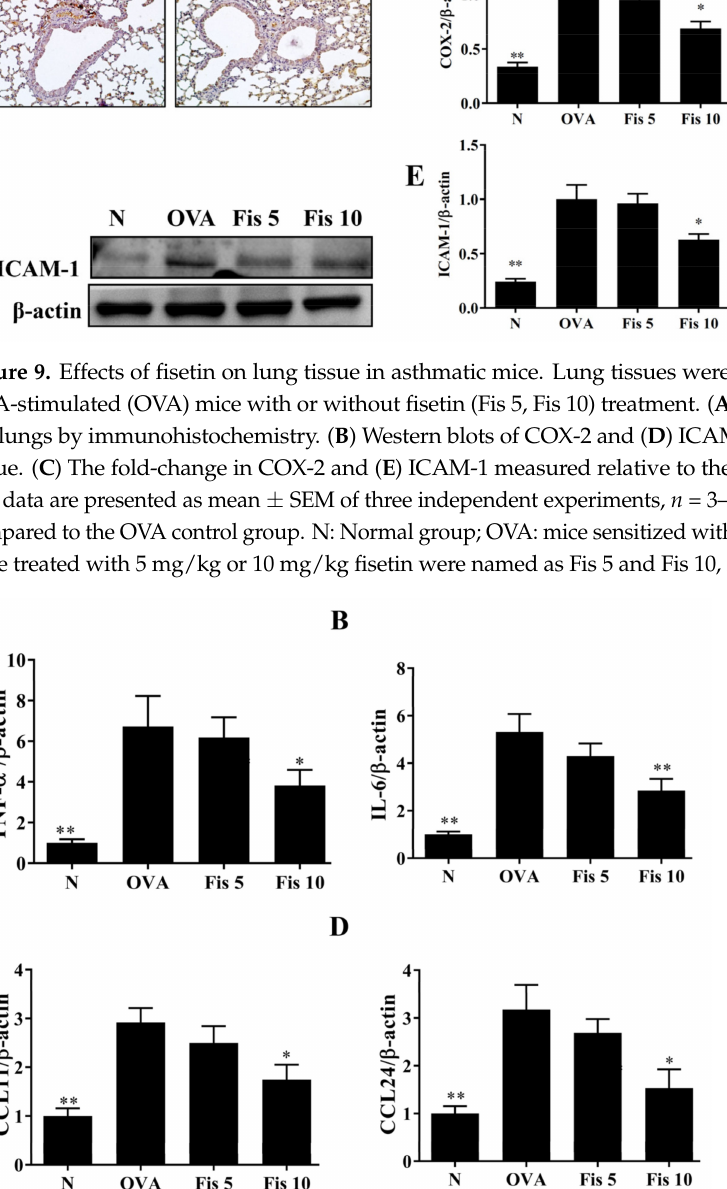
Figure 10. Gene expression in lung tissue from normal (N) and OVA-stimulated (OVA) mice with or without fisetin (Fis 5, Fis 10) treatment. ( A ) TNF- α , ( B ) IL-6 , ( C ) CCL11, ( D ) CCL24 . Fold changes in expression were measured relative to β -actin. The data are presented as mean ± SEM of three indepen- dent experiments, n = 6. * p < 0.05, ** p < 0.01, compared to the OVA control group. N: Normal group; OVA: mice sensitized with OVA. OVA-sensitized mice treated with 5 mg/kg or 10 mg/kg fisetin were named as Fis 5 and Fis 10,